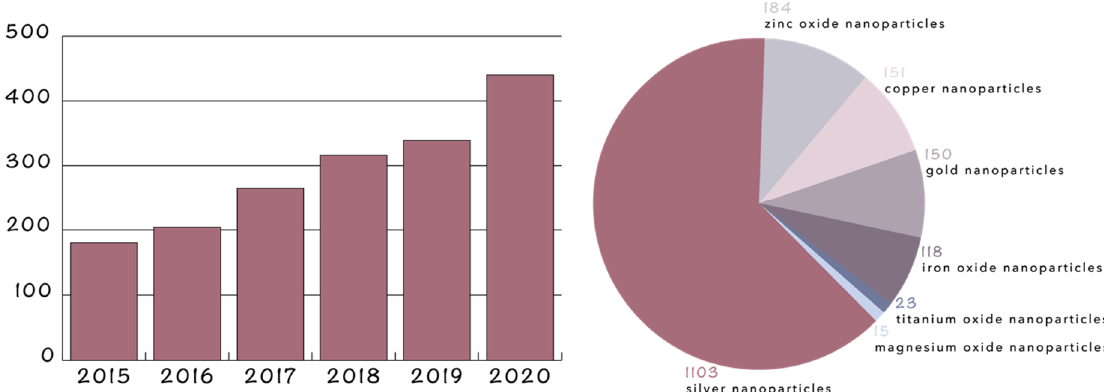
Figure 4. Number of publications between 2015 and 2020 ( left ) and for each type of NPs ( right ) for AuNPs, AgNPs, CuNPs, ZnO NPs, TiO 2 NPs, MgO NPs, and Fe 3 O 4 NPs.